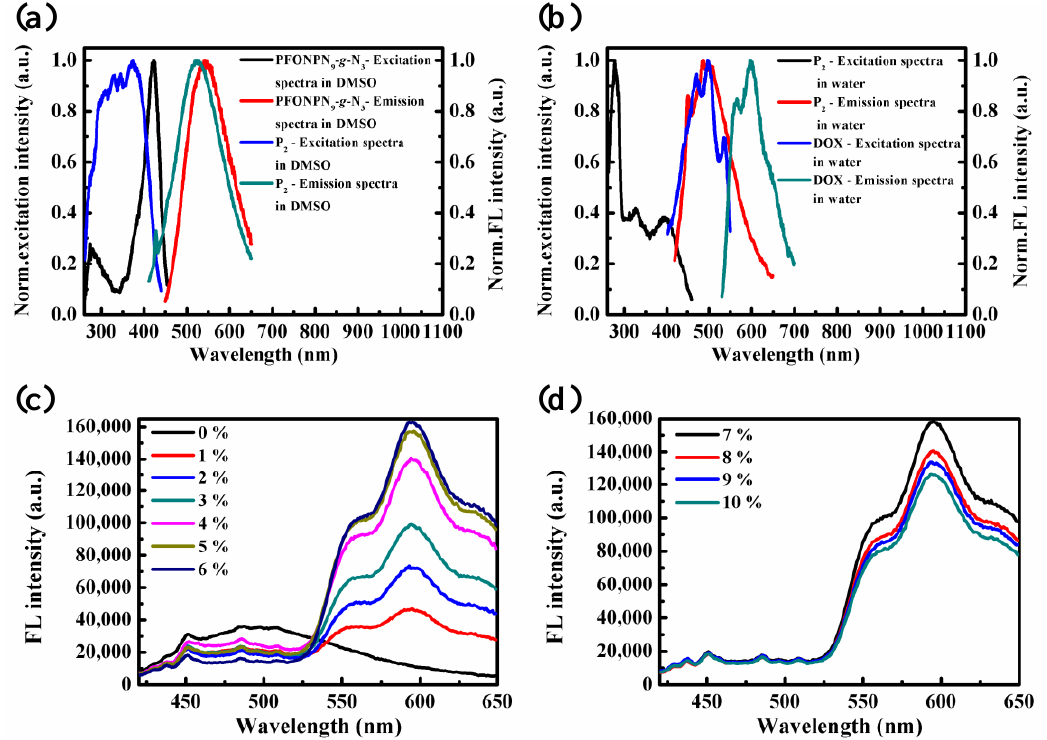
Figure 8. Fluorescence excitation and emission spectra of the conjugated backbone of PFONPN and P 2 in DMSO ( a ), as well as P 2 and DOX in water ( b ), and fluorescence emission spectra of P 2 added with a different feed ratio of DOX from 1 – 6% ( c ) and 7 – 10% ( d ) with excitation at 390 nm in water.